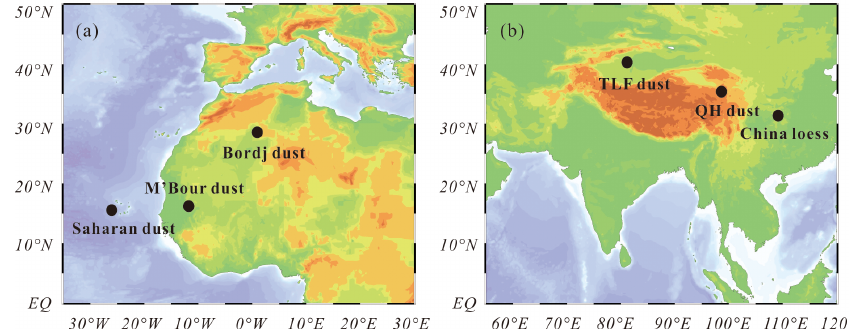
Figure 1. Locations where (a) African and (b) Asian authentic mineral dust samples examined in this work were collected.